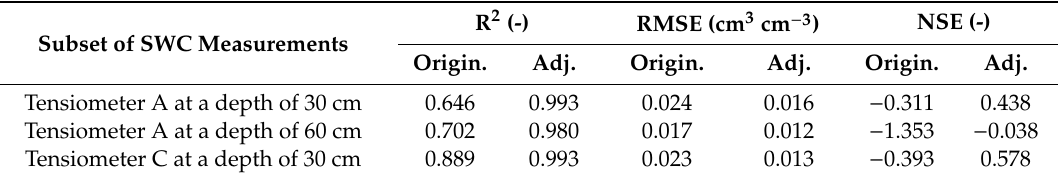
Figure 9. Comparison between soil water dynamics in the validation dataset relating to 2017, simulated with HYDRUS-3D and measured using neutron probes. The simulations were based on HYPROP + WP4C parameterization. This was either unmodified or modified with parameter n empirically adjusted in line with the dataset for 2018. Table 10. Summary of the fit between soil water content (cm 3 cm − 3 ) estimated from tensiometers during July 2017 and HYDRUS-3D simulations parameterized from HYPROP + WP4C (Origin.), and simulations parameterized from HYPROP + WP4C, with the exception of n, which was calibrated from the 2018 dataset